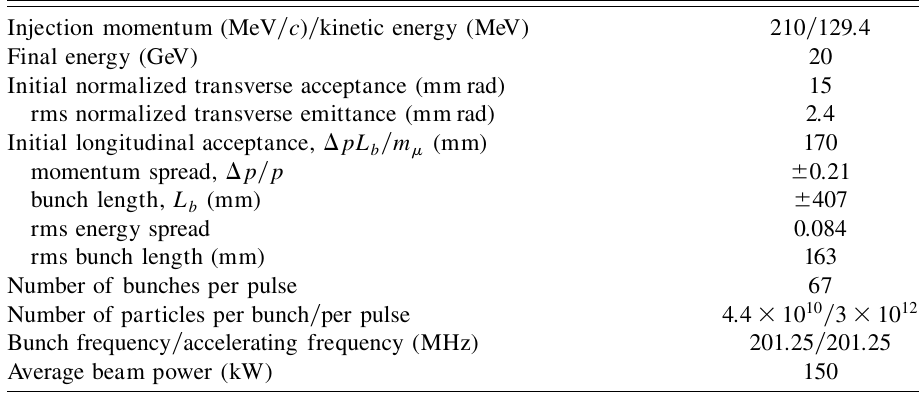
TABLE VIII. Main parameters of the muon accelerator.